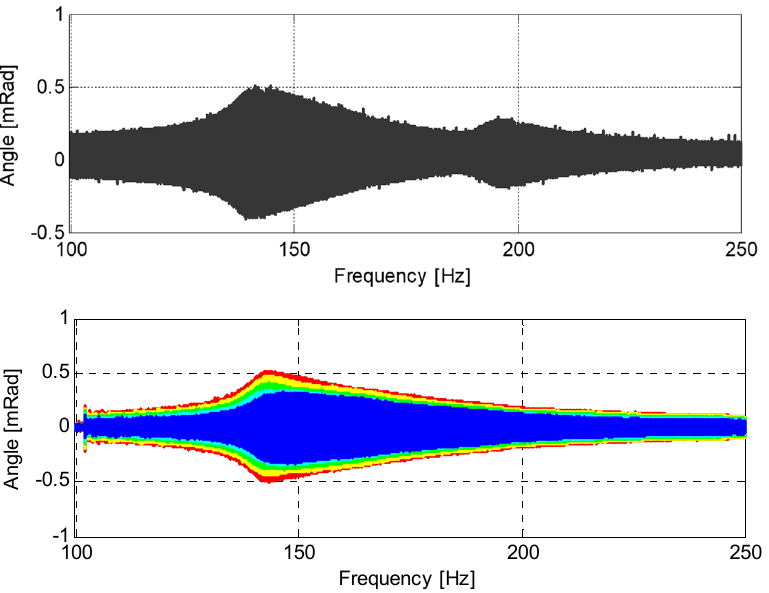
Figure 20. The results of RC testing. Standard RC test results are at the top; the results from the additional accelerometers are at the bottom. Material: saclSi 1; Isotropic pressure 50 kPa; Frequency spectrum 100–250 Hz; Excitation (torque) amplitude 2 V (– original built-in sensor, – the top sensor, S1, – the second sensor from the top, S2, – the third sensor from the top, S3, – the fourth sensor from the top, S4, – the bottom sensor, S5).